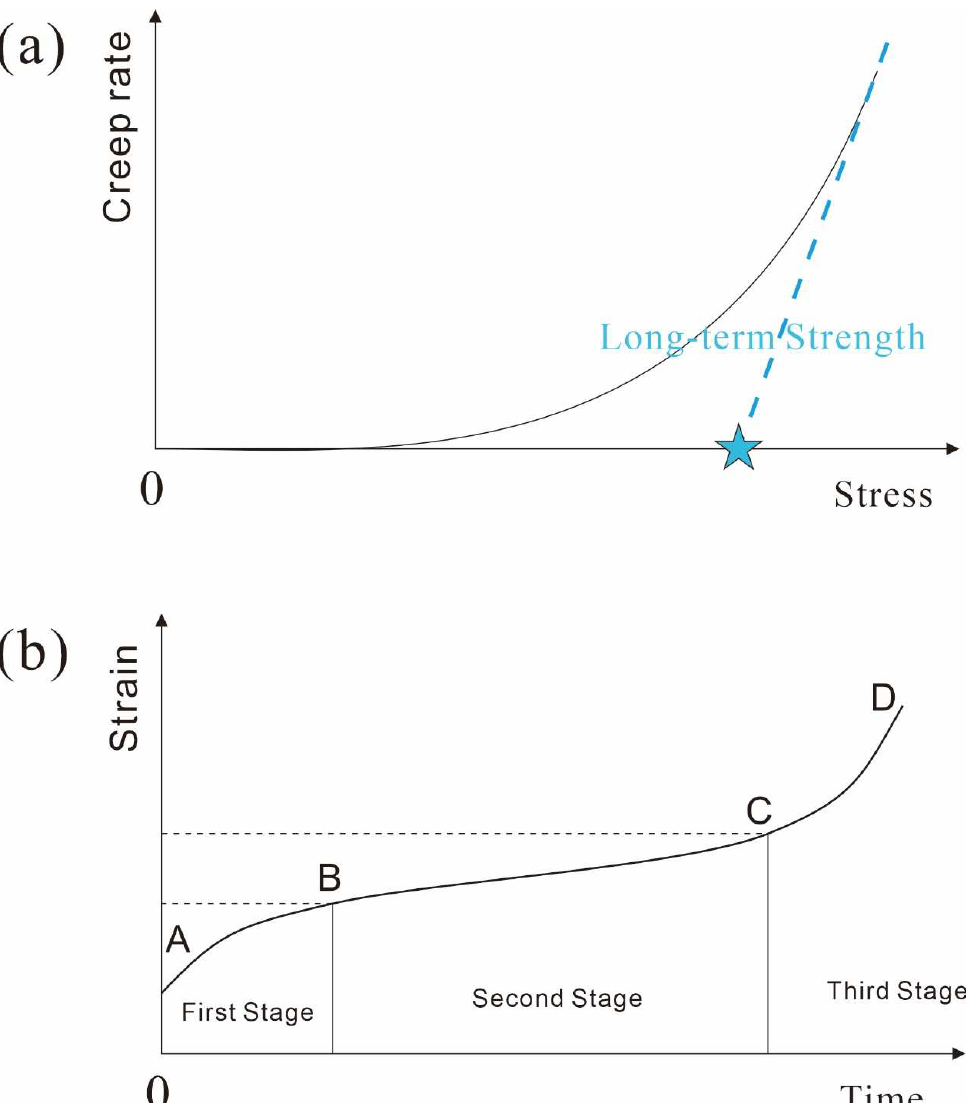
Figure 17. ( a ) The steady-state creep rate method to determine the long-term strength. ( b ) Creep process curve; A-D represents the dividing point of each creep stage.